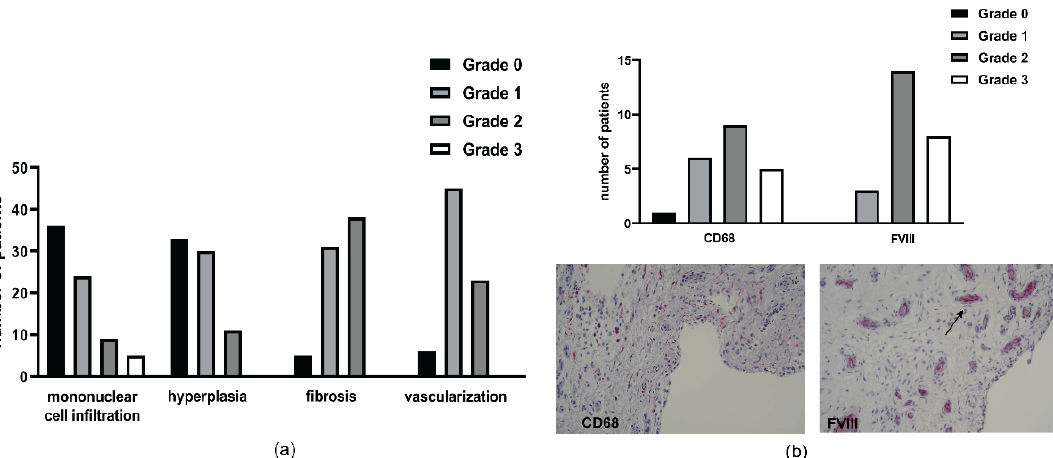
Figure 1. Histological and immunohistochemical analysis of synovial tissue. ( a ) synovial inflammation evaluated according to the histological synovial scoring system considering the following parameters graded from 0 to 3: mononuclear cell infiltration, hyperplasia, fibrosis and vascularization. ( b ) in the upper part: number of patients with different grades of production of CD68 and FVIII; bottom part: a representative patient exhibits high ‐ grade CD68 production (10 × magnification) and FVIII (grade 3, 20 × magnification; the arrow points to immunohistochemical staining for factor VIII ‐ related antigen, the marker for endothelial cells of vessels).